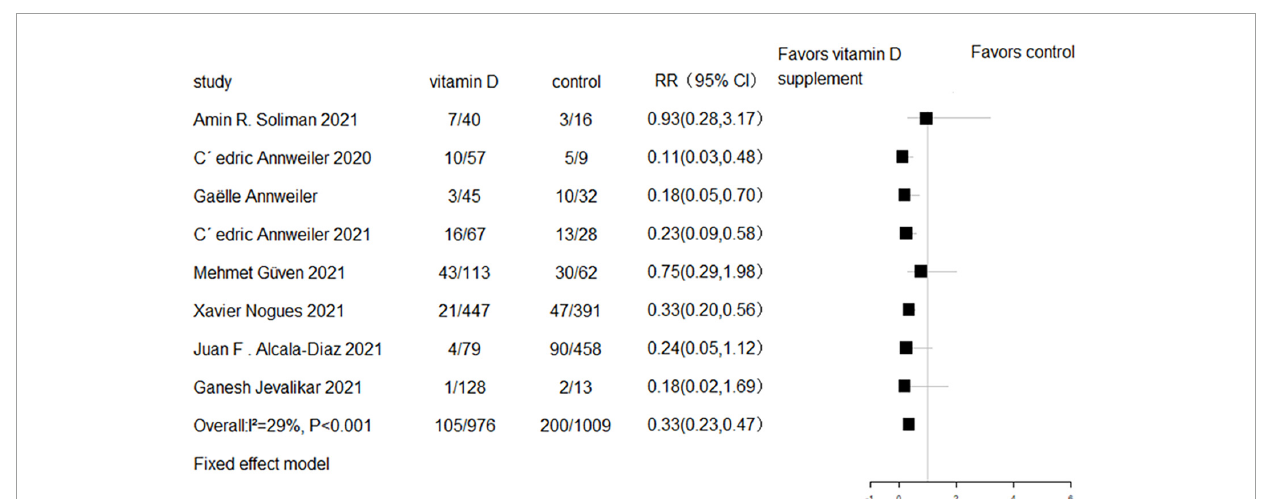
FIGURE3 Forest plot of cohort studies for vitamin D supplementation on mortality (All cohort studies).